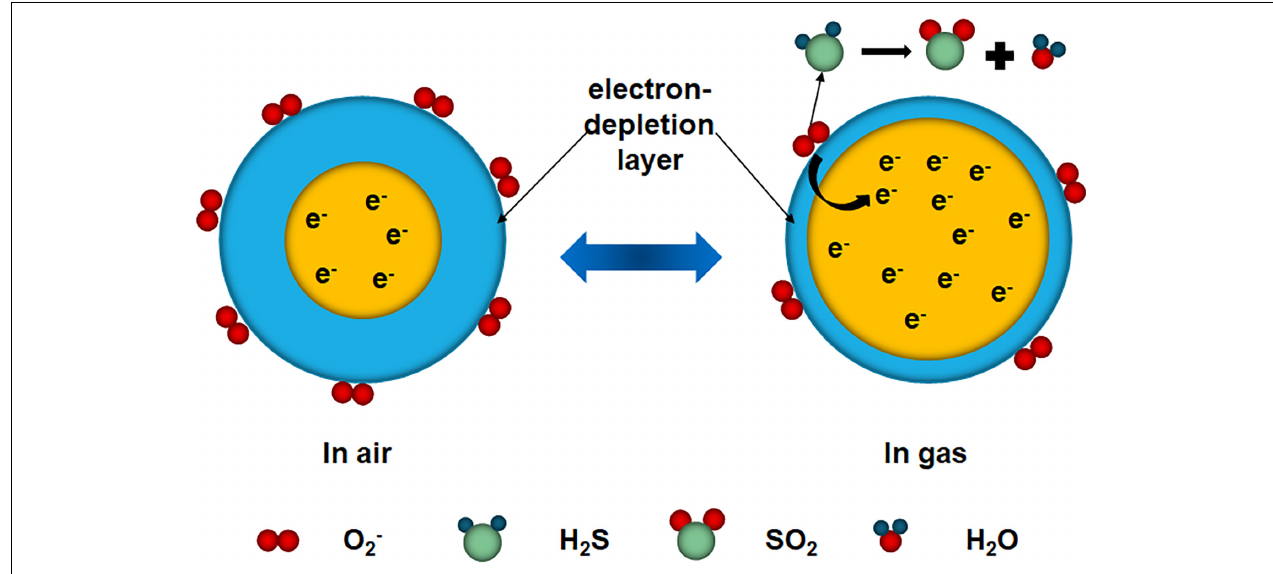
FIGURE 5 | Schematic diagram of H 2 S sensing mechanism of